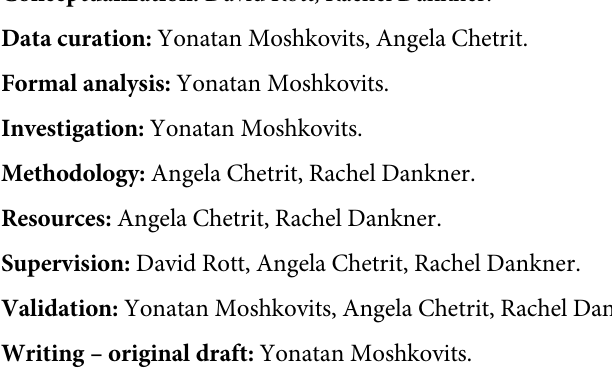
S1 Table. Distribution of malignancy attributed causes of